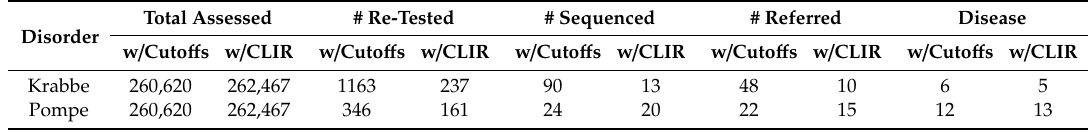
Table 2. Number of specimens at each stage of screening during the first year of Collaborative Laboratory Integrated Reports (CLIR) tool use compared to the year prior. Disease refers to the number of true